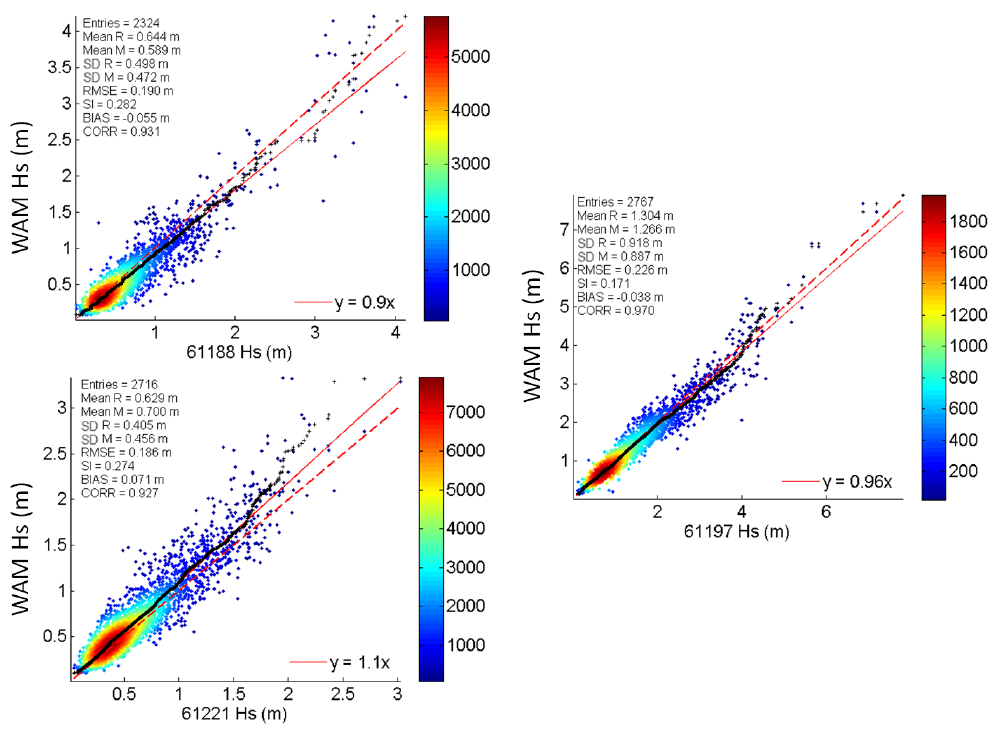
Figure 5. QQ–scatter plots of Med-waves output H s versus wave buoy observations at specific wave buoy locations, for a 1-year pe- riod (2014): QQ plot (black crosses), 45 ◦ reference line (dashed red line), and least-squares best-fit line (red